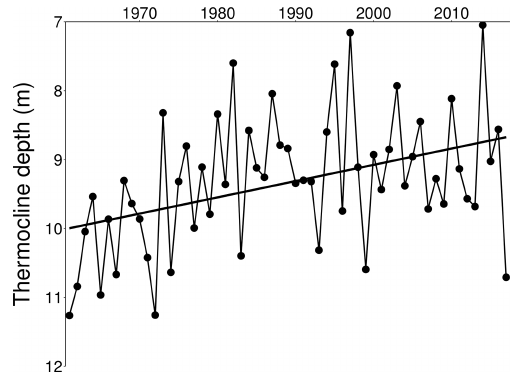
Figure 10. Mean annual thermocline depth between 1961 and 2017 (Sens’s slope: − 0 . 236m per decade, p < 0 .